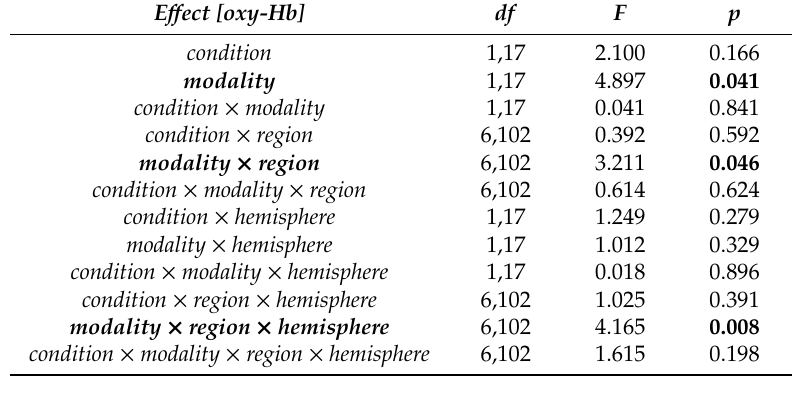
Table 3. Statistical results of the ANOVA condition × modality × region × hemisphere for [oxy-Hb] of